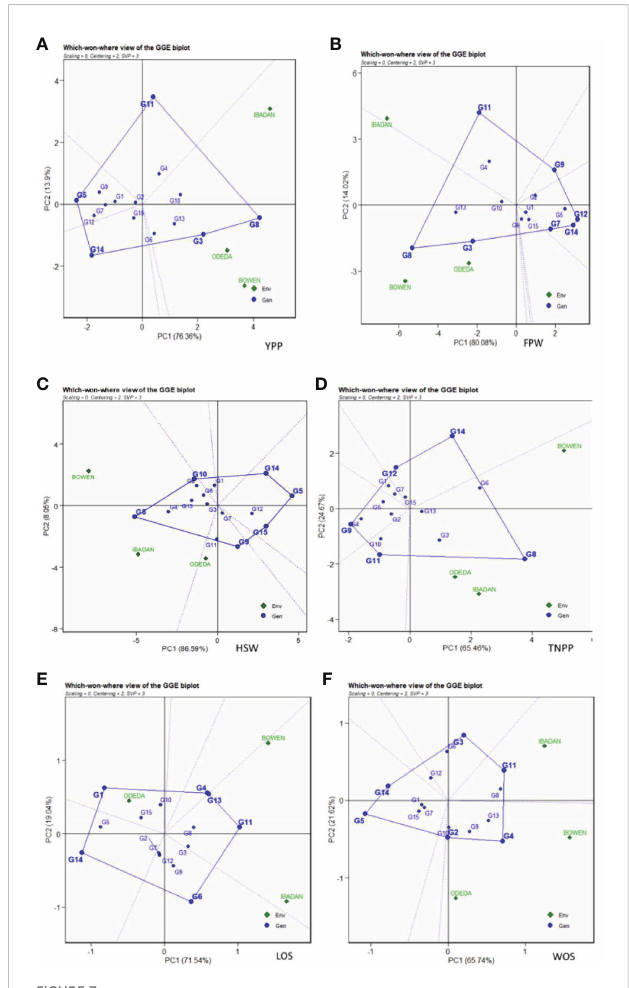
FIGURE 7 Patterns (A – F) . Polygon views of GGE biplot for which-won-where analysis of 15 accessions under the effects of genotypes-by- environment interactions: (A) yield per plant (YPP), (B) fresh pod weight (FPW), (C) hundred seed weight (HSW), (D) total no. of pods per plant (TNPP), (E) length of seeds (LOS), and (F) width of seeds (WOS). The GGE biplot polygons were based on scaling = 0, centering = 2, and singular value partitioning (SVP) =